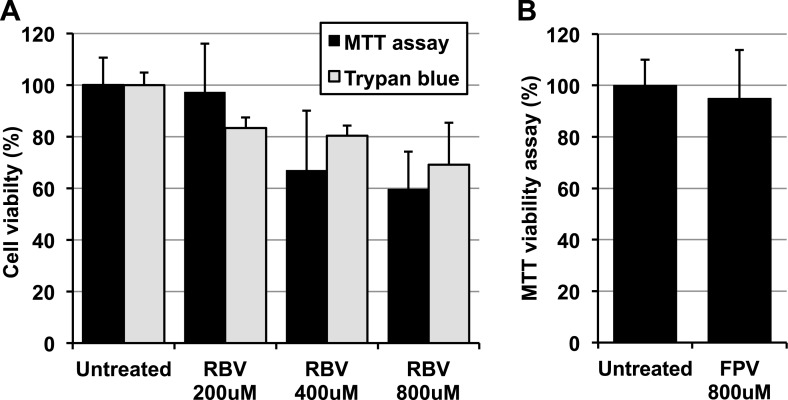
Favipiravir and ribavirin toxicity in RAW264.7 cells.(A) Ribavirin toxicity upon RAW264.7 cells was scored using both trypan blue, which measures the proportion of dead cells, and CellTiter-Blue Cell Viability Assay (Promega), which accounts for living active cells. (B) Favipiravir toxicity was determined by CellTiter-Blue Cell Viability Assay (Promega).